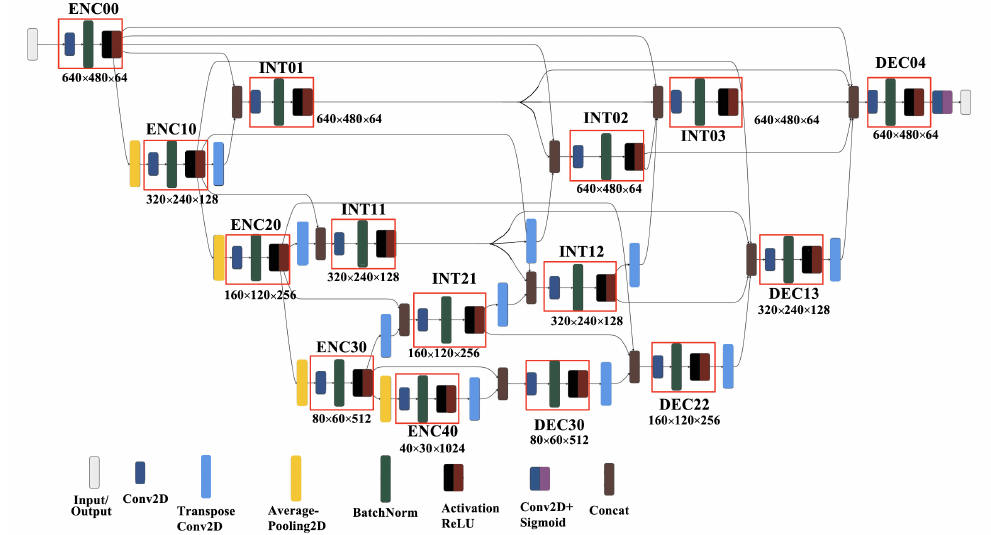
Figure 9. Our implementation of